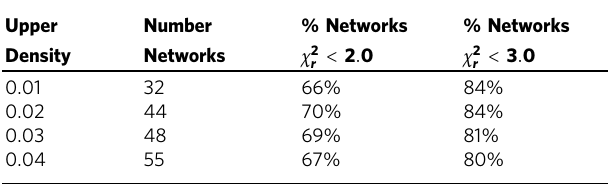
Table 3 The success rate for sparse Netzschleuder networks.